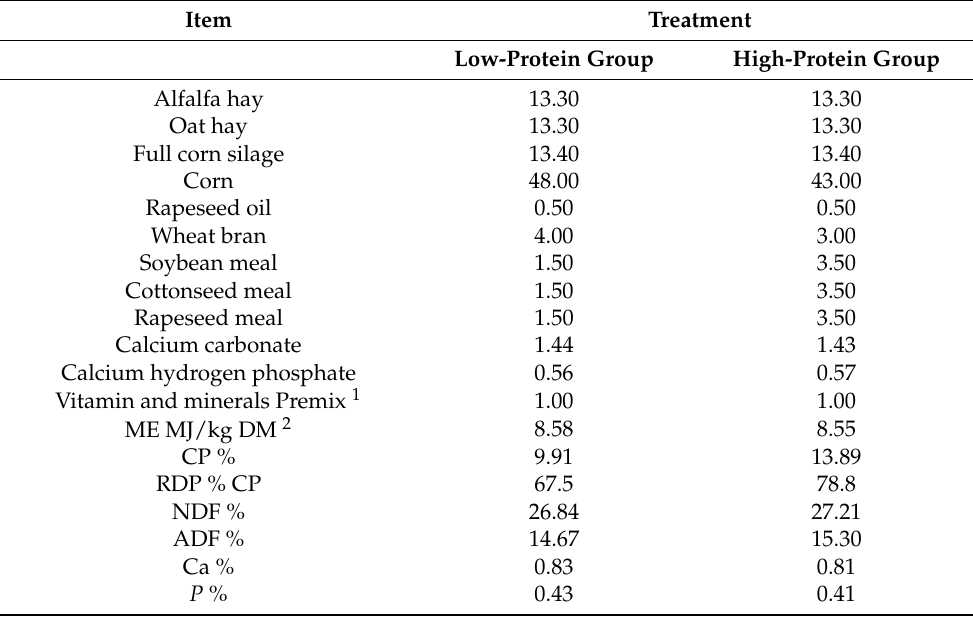
Table 1. Ingredients and chemical composition of the experimental